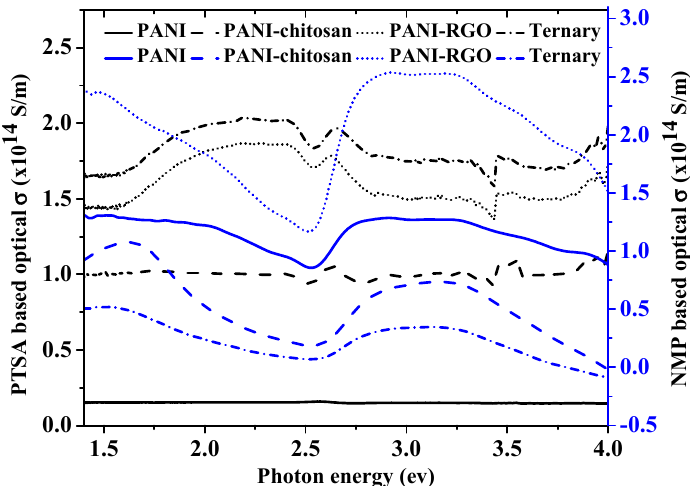
Figure 5. The optical conductivity values, σ versus incident photon energy for PANI, PANI-chitosan, PANI-RGO and Ternary composite.